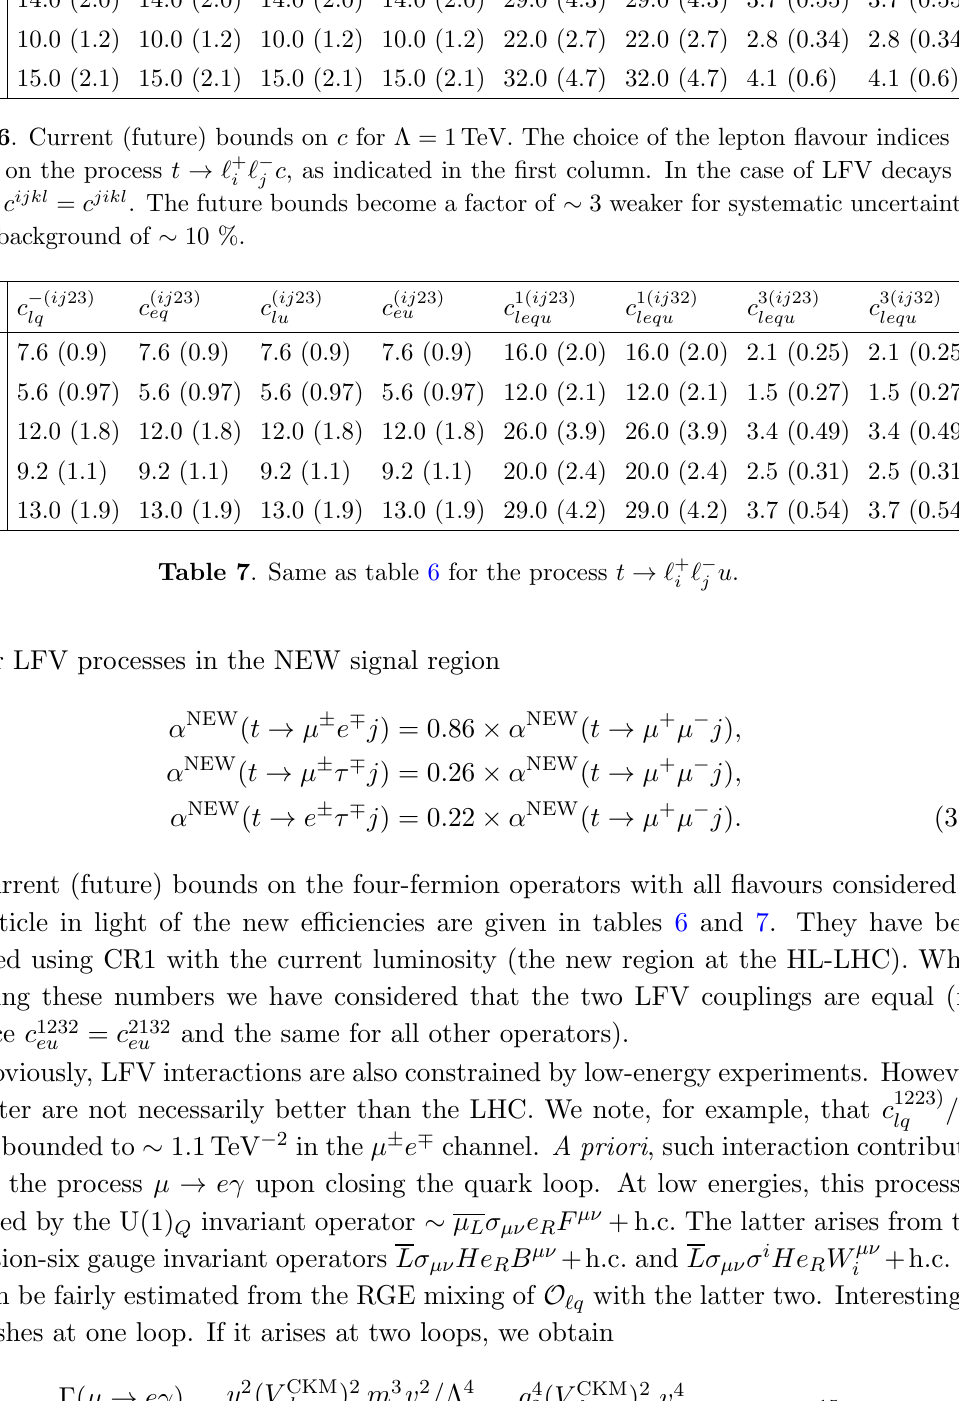
3 weaker for systematic uncertainties (cid:24)